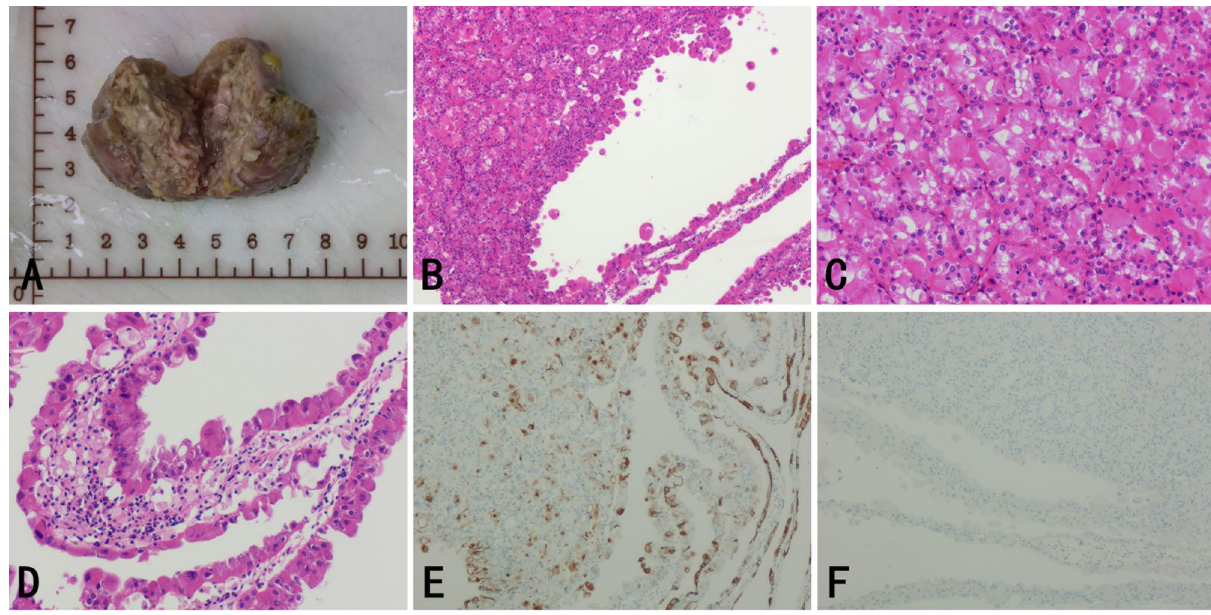
Fig. 2 Pathological characteristics of the tumor: A, The gross tumor showed Clear boundaries on cut surface; B, The tumor showed solid and cystic structures, tumor cells were rich in eosinophilic cyto- plasm. HE staining with magnification ×40; C, Solid areas: The tumor cells were arranged in a nest and sheet. HE staining with magnification ×100; D, Cystic areas: The tumor cells were arranged in hobnail-like, Foam cells and lymphocytes infiltration were observed in the stroma. HE staining with magnification × 100; E, The tumor cells were focal positive expression of CK20. Staining by the En Vision method with magnification ×40; F, The tumor cells were negative of CK7. En Vision method with magnification ×